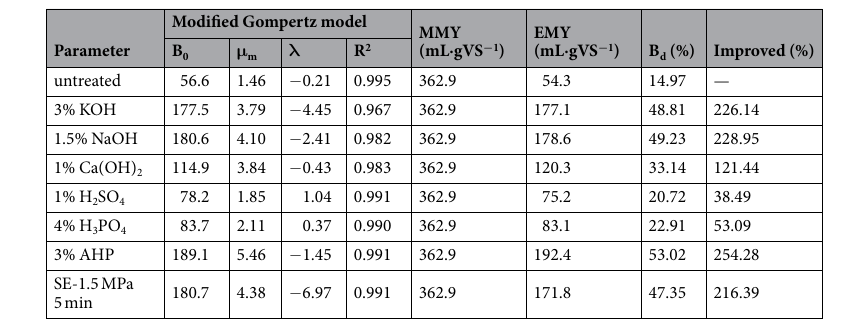
Table 2. The biodegradability of CS after pretreatment and kinetic parameters of the Modified Gompertz model.